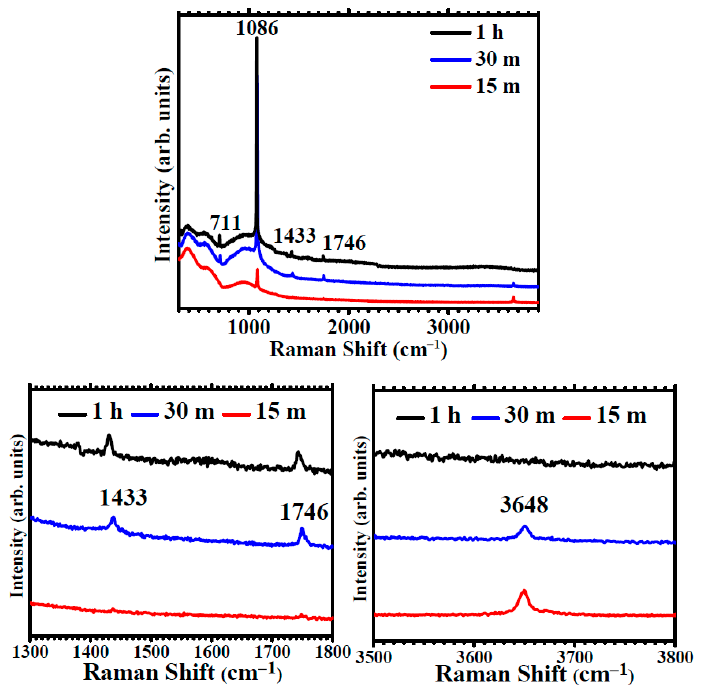
Figure 5. Raman spectra showing the evolution for immersion times in carbonated water of 15 min, 30 min and 1h and details of the spectral regions of the Eg modes of calcite at 1300–1800 cm − 1 and of OH stretching at 3500–3800 cm − 1